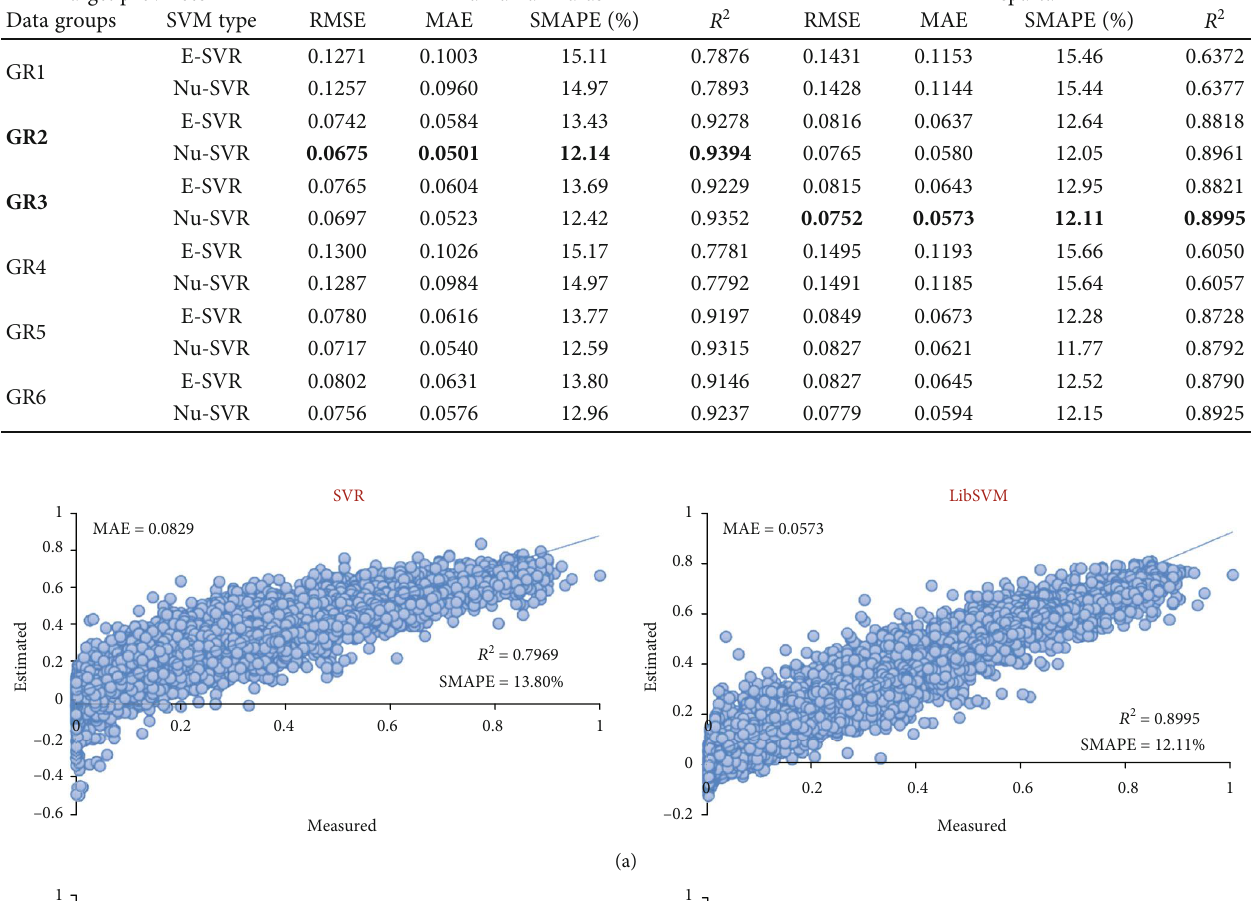
Table 9: Estimation results of the most successful models that were developed according to LibSVM and the input data of both provinces. Target